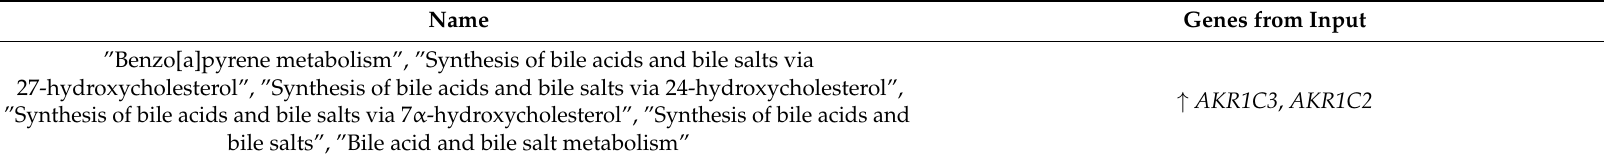
Table 2. Top ranked over-represented pathways shared by all DEP extract treatments following 4 h incubation. Functional enrichment was performed using ToppFun tool integrating numerous annotation databases. Significant upregulation resp. downregulation of genes: ↑↓